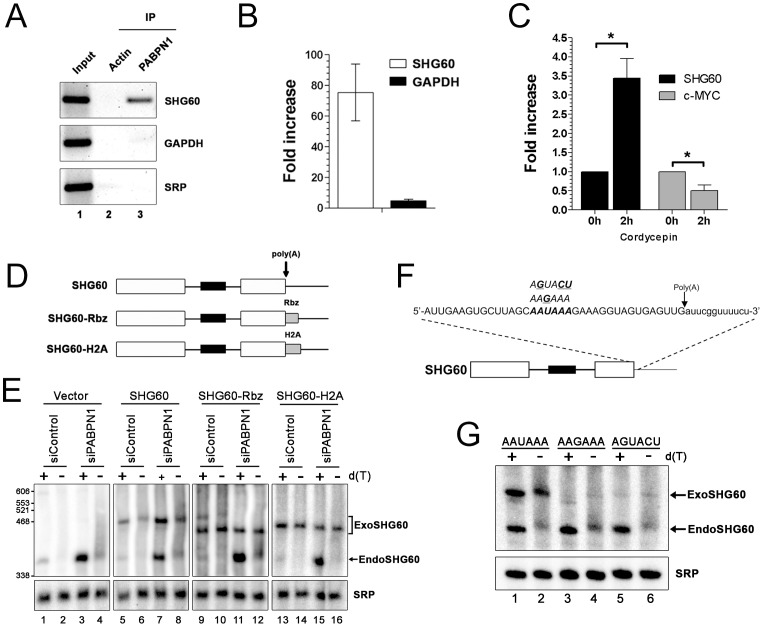
PABPN1–dependent RNA decay is polyadenylation-dependent.(A) Immunoprecipitation (IP) experiments showing that the SHG60 lncRNA is enriched in PABPN1 precipitates, but not in a control purification. The GAPDH mRNA and the SRP noncoding RNA were used as controls. (B) RNA enrichments (IP∶input ratio) in PABPN1 and control purifications were determined by real-time RT-PCR for the SHG60 RNA, the GAPDH mRNA, and the SRP RNA. Fold changes are relative to the control actin IP and normalized to the SRP RNA. The data and error bars represent the average and standard deviation from four independent experiments. (C) Quantitative RT-PCR analysis of RNA prepared from HeLa cells that were previously treated or not treated with cordycepin for 2 h. Fold increases are relative to untreated cells and normalized to the nonpolyadenylated SRP RNA. The data and error bars represent the average and standard deviation from three independent experiments. * p<0.05; Student's t-test. (D) Schematic diagram of the SHG60 constructs. White rectangles represent the noncoding exons, whereas the black box corresponds to the intronic SNORD60. The arrow indicates the position of the polyadenylation site as determined by 3′ RACE. The RBZ and H2A grey boxes correspond to the ribozyme and H2A terminator sequences, respectively. (E) HeLa cells treated with PABPN1–specific and control siRNAs were transfected with the control vector (lanes 1–4) or DNA constructs that express normal (lanes 5–8), ribozyme-processed (lanes 9–12), and H2A-processed (lanes 13–16) SHG60 lncRNA. Total RNA was treated with RNase H in the presence (+) or absence (−) of oligo(dT) before northern analysis using a SHG60-specific probe. The position of exogenous and endogenous SHG60 lncRNA is indicated on the right. The SRP RNA was used as a loading control. (F) The AAUAAA hexamer sequence of the SHG60 poly(A) signal is shown in bold with the two different hexamer variants used shown above the AAUAAA hexamer. The arrow shows the position of the SHG60 polyadenylation site, as determined by 3′ RACE. (G) HeLa cells were transfected with DNA constructs that express AAUAAA (lanes 1–2), AAGAAA (lanes 3–4), and AGUACU (lanes 5–6) SHG60 lncRNA. Endogenous and exogenous SHG60 lncRNA were detected in PABPN1–expressing conditions as shown in E (lanes 5–6).